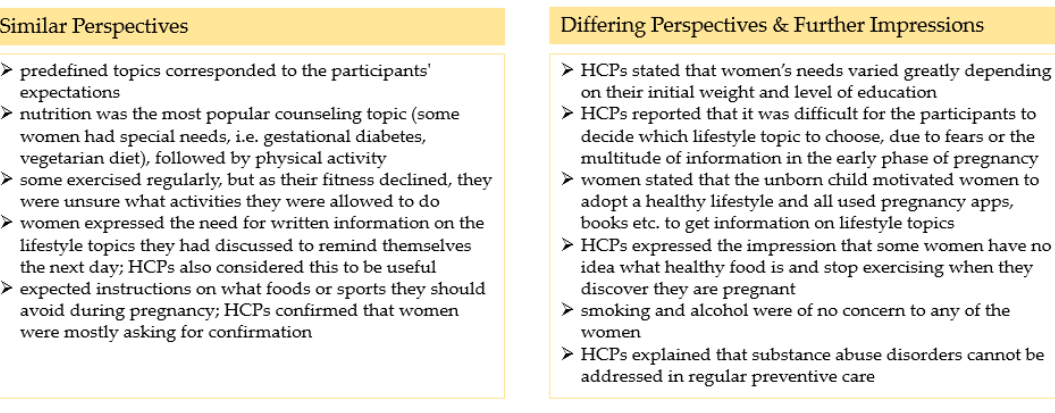
Figure 3. Summary of the results in Section